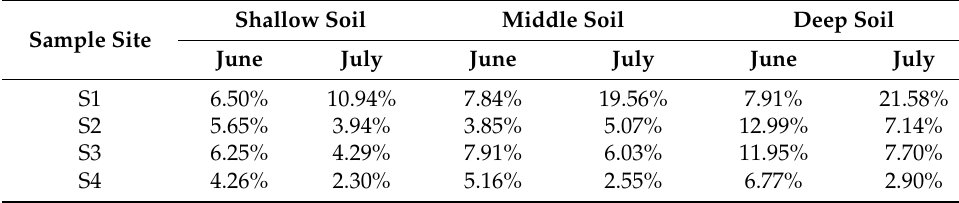
Table 1. The soil water content of sample sites at different periods.